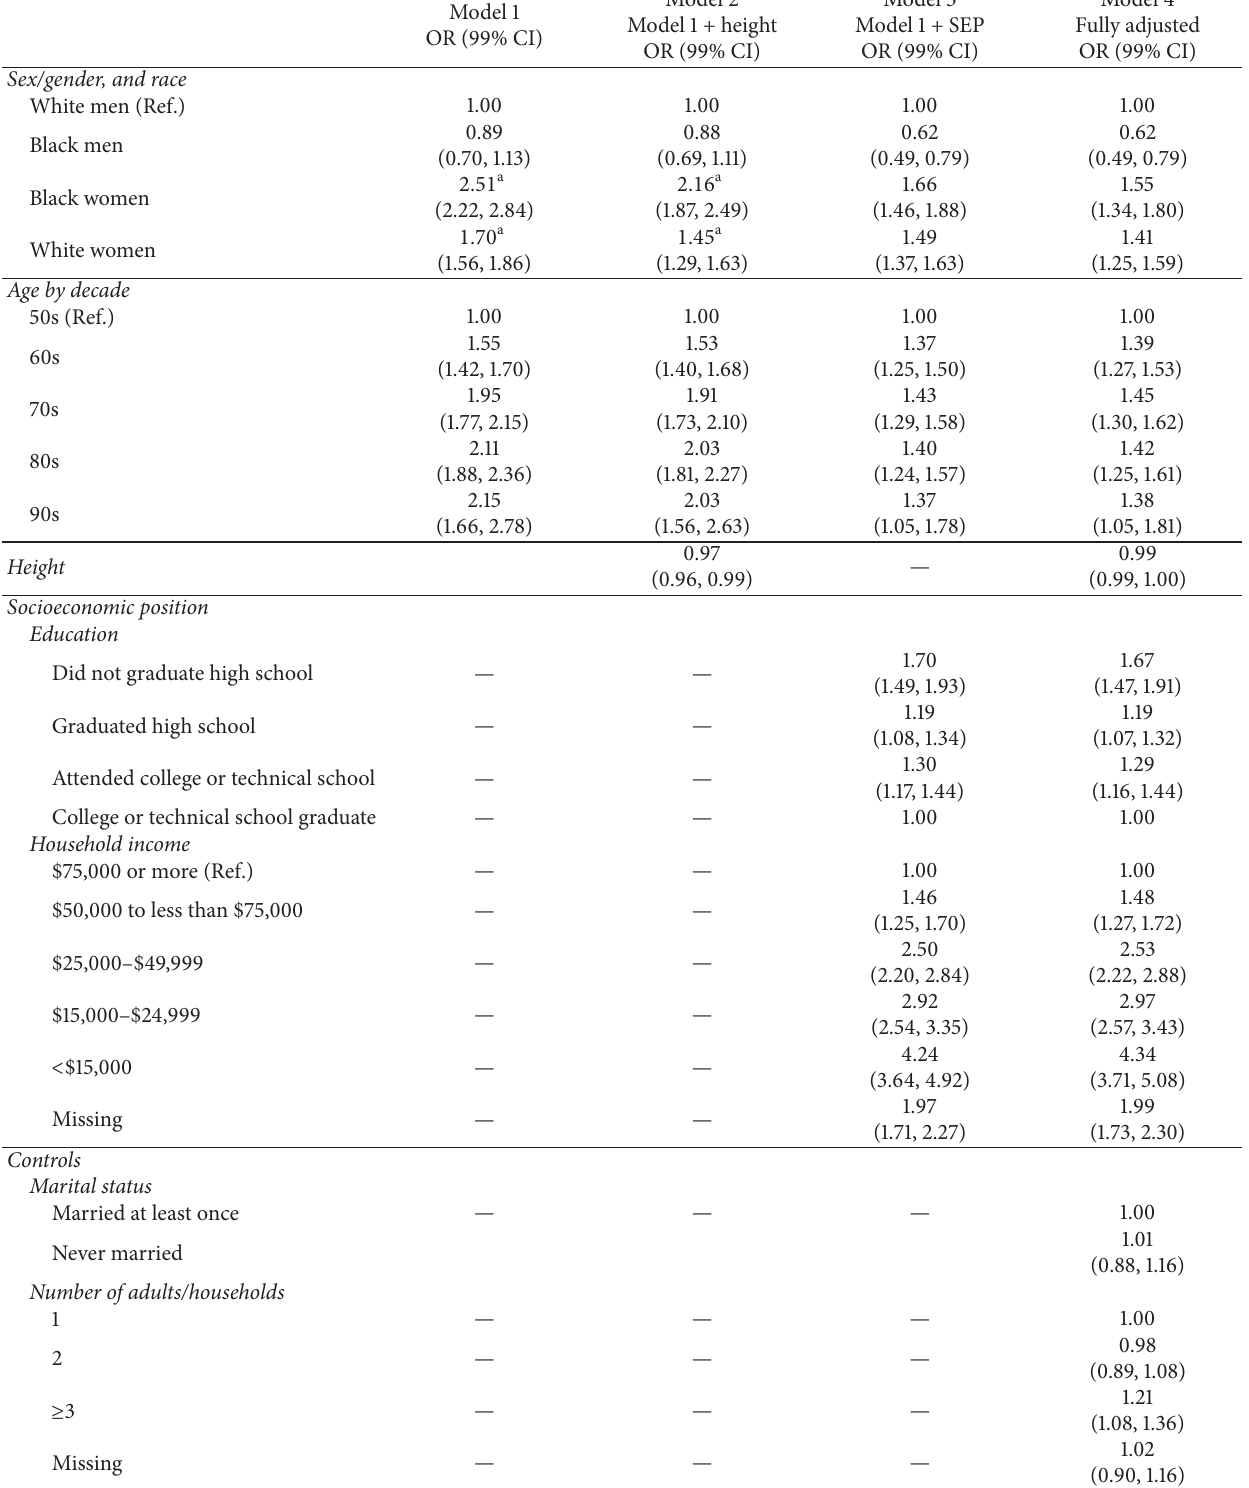
Table 2: Logistic regression of COPD by sex/gender and race in a sample of never-smoking Americans over the age of 50 ( 𝑛 = 129 , 535 ) 1